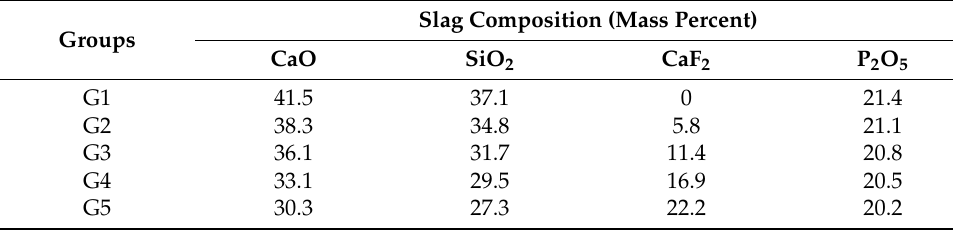
Table 3. The chemical compositions of experimental slags.